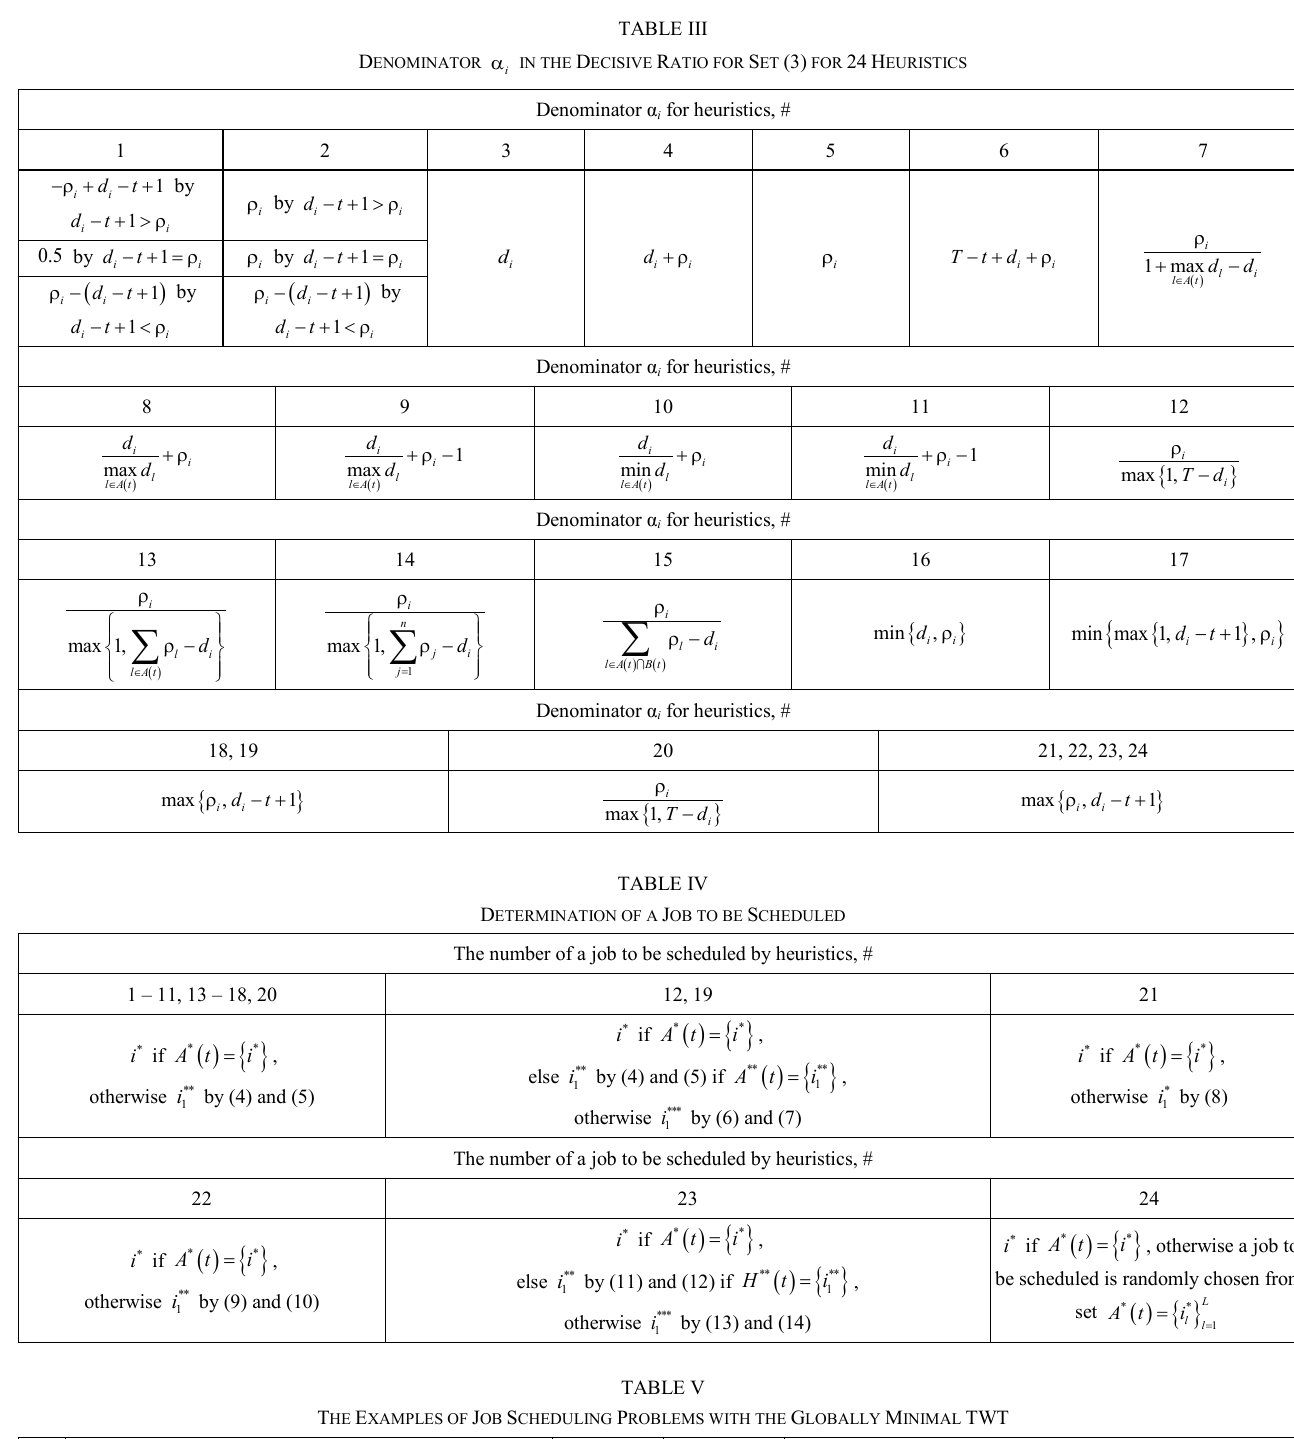
Globally Exact TWT minimal minimum TWT